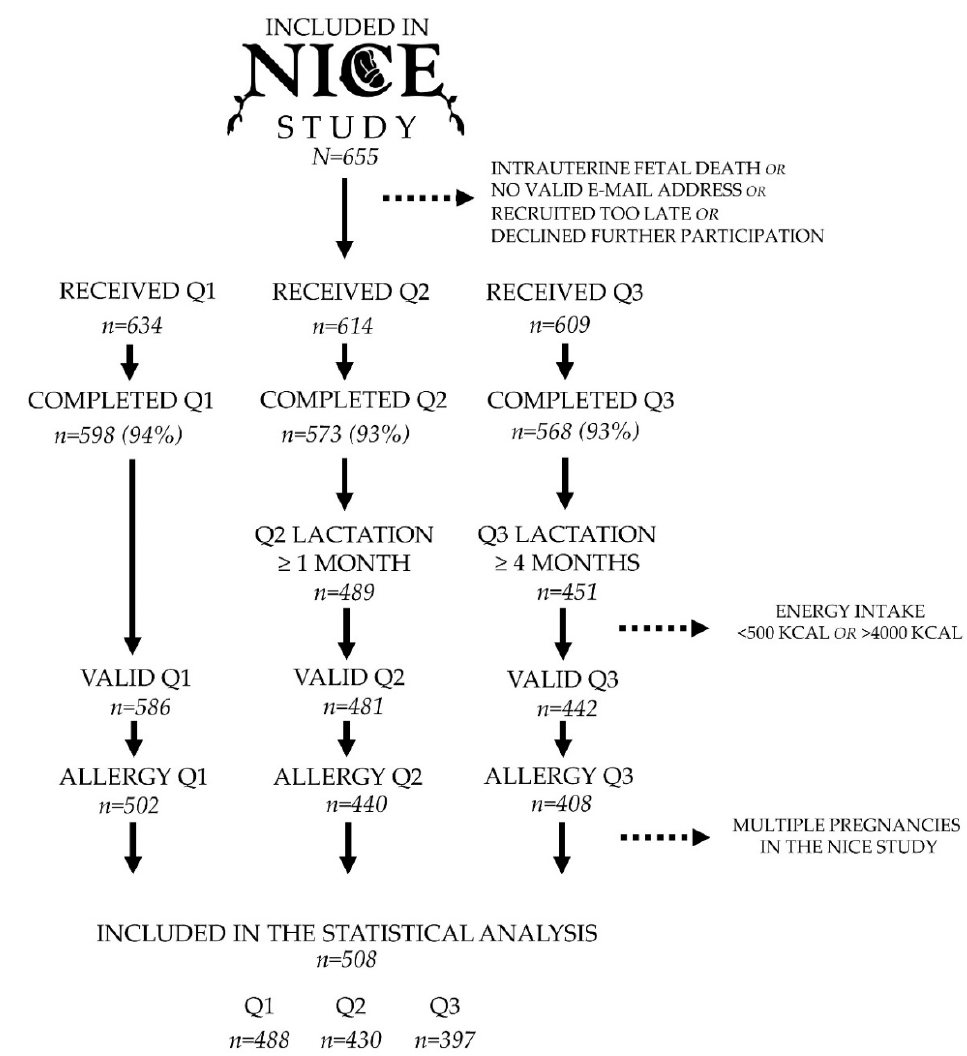
Figure 1. Flowchart of inclusion and exclusion in the present study. Dietary data were collected at three separate time-points: Gestational Week 34 (Q1), 1 month postpartum (Q2), and 4 months postpartum (Q3). All the families were invited to a follow-up visit at 12 months of age (Allergy Q1, Allergy Q2, and Allergy Q3) with a pediatrician specialized in allergy.